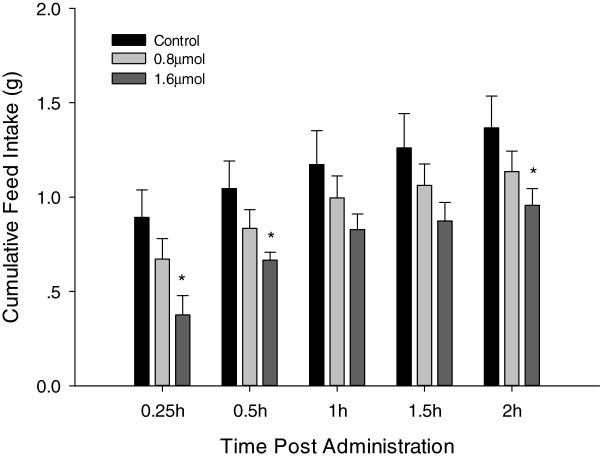
Cumulative feed intake of broiler chicks after ICV administration with saline (control, n = 9), 0.8 μmol (n = 10) or 1.6 μmol (n = 7) L-glutamate. Feed intake was recorded at 0.25, 0.5, 1, 1.5, and 2 h post-administration; Data are represented as means ± S.E.M. Asterisk indicates significant difference from control group within each time point (P < 0.05).